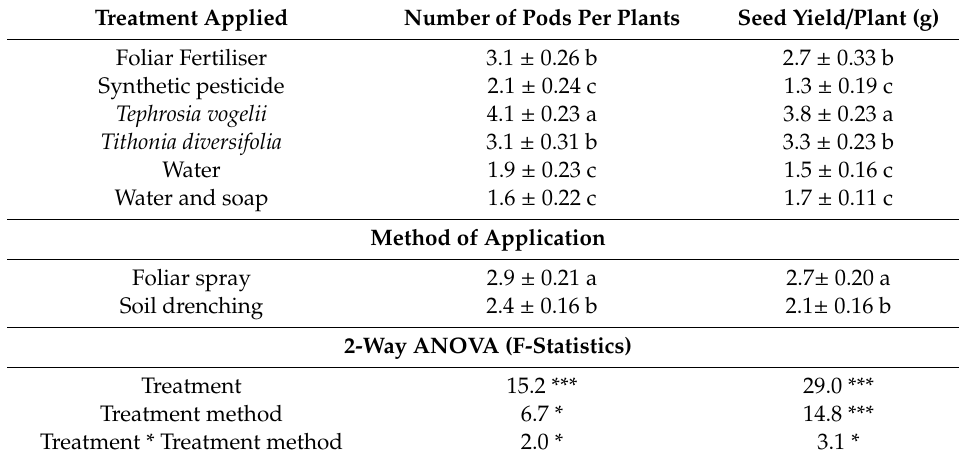
Table 1. E ff ects of foliar fertiliser, synthetic and plant pesticide treatments and application method on the yield of common